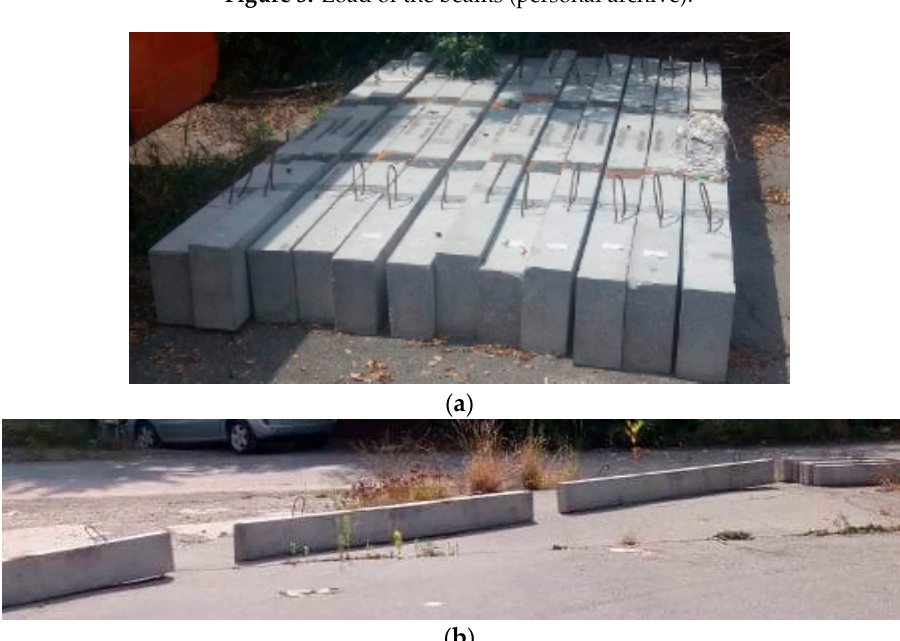
Figure 4. The 12 beams—series A to D, ( a ) subject to external atmospheric impacts, ( b ) preparation for measurements (personal archive).